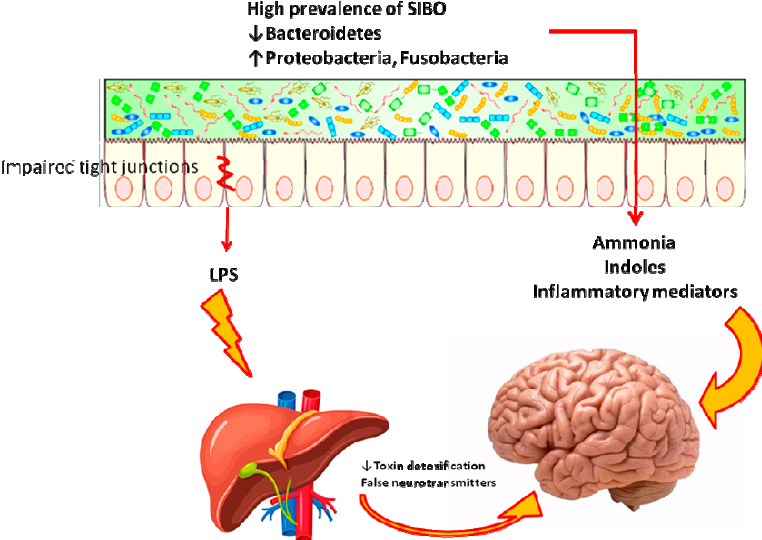
Figure 2. Role of SIBO and gut microbiota in the pathogenesis of hepatic encephalopathy. Both SIBO and a dysbiosis with low Bacteroidetes and high Proteobacteria and Fusobacteria may contribute to the pathogenesis of HE, by engendering a damage to tight junctions and producing toxins and ammonia which, in turn, worsen